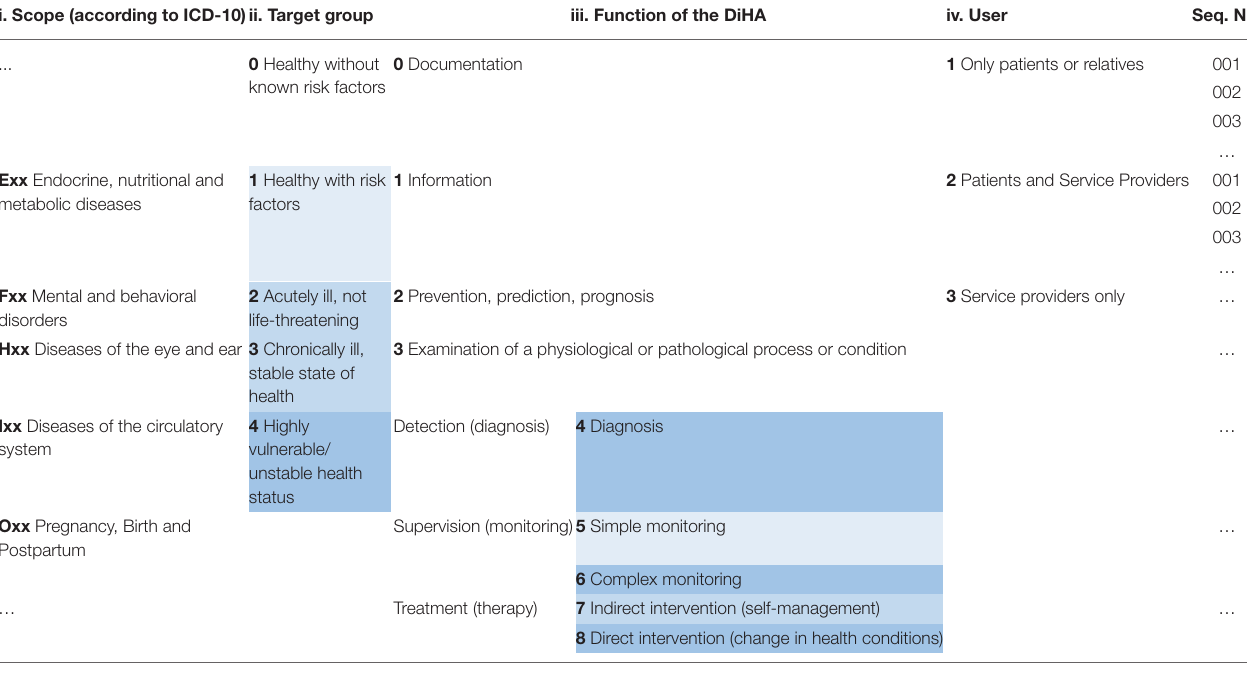
TABLE 1 | Proposal for DiHA directory with criterion values and correspondence to evidence requirement levels (blue shading). i. Scope (according to ICD-10)ii. Target